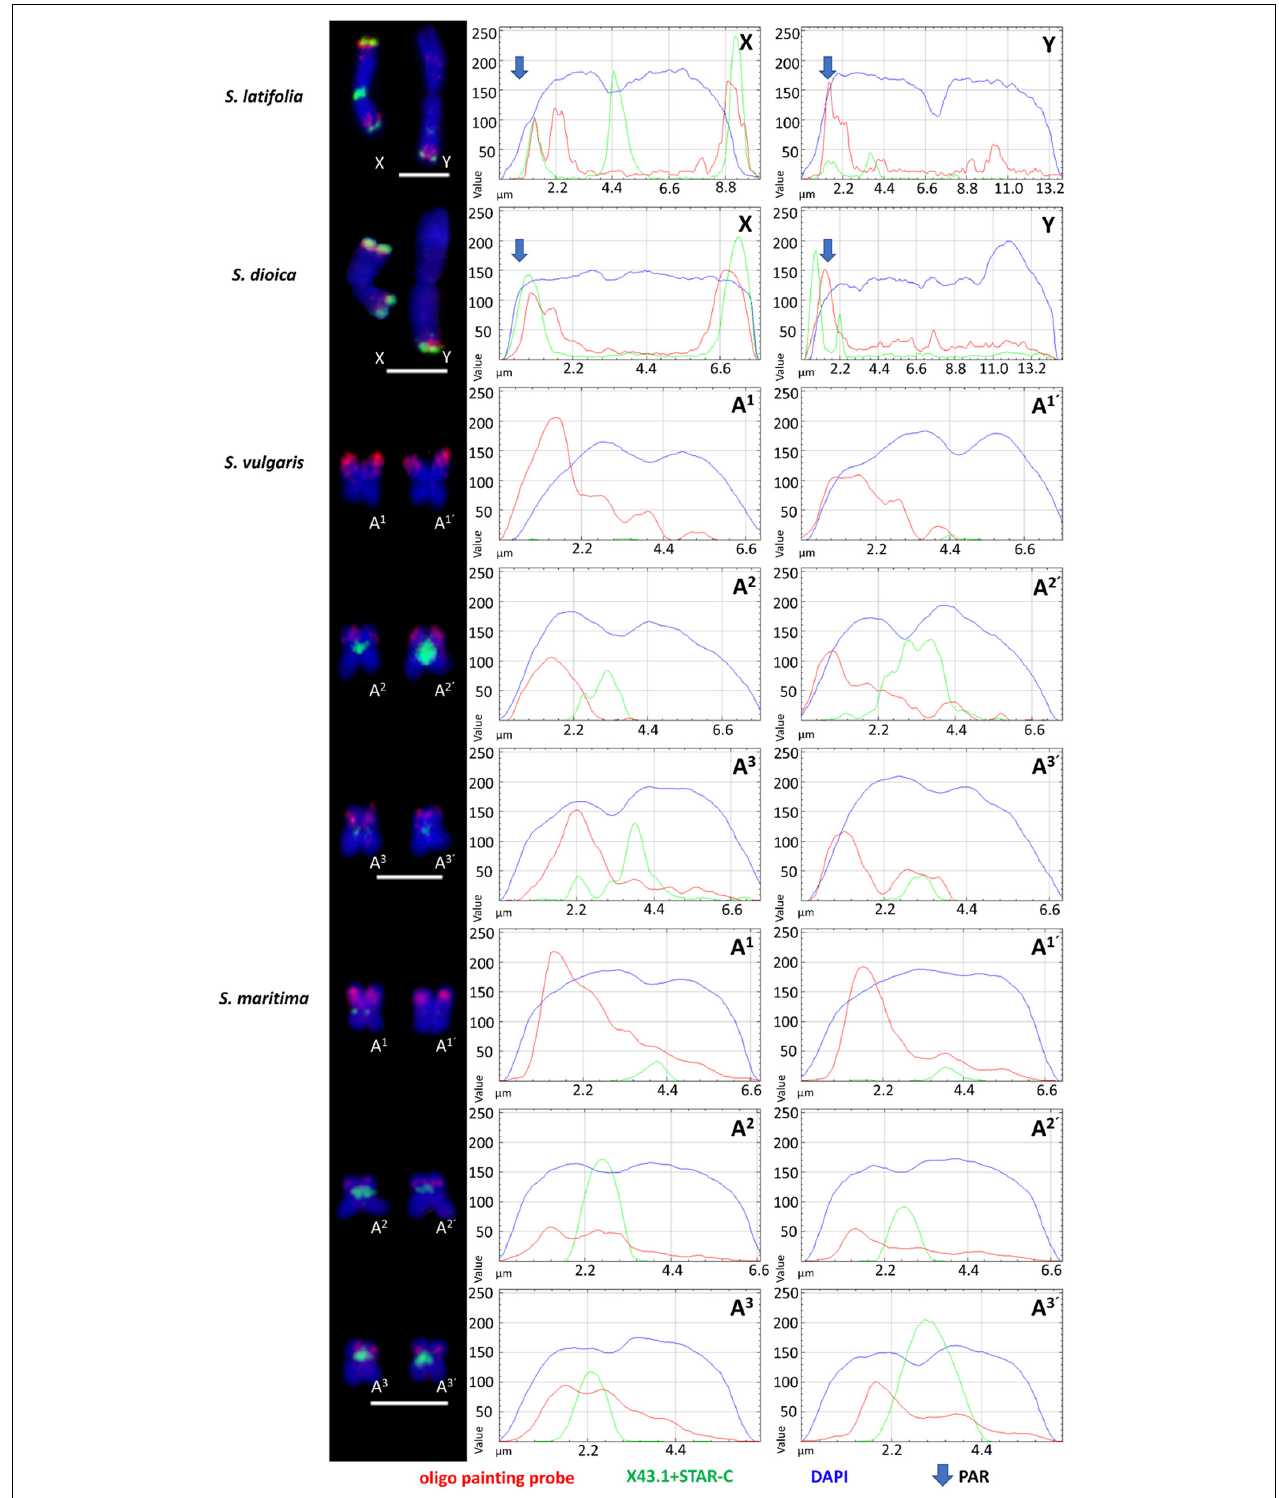
FIGURE 2 | Schematic distribution of X chromosome-specific oligo probe on sex chromosomes in S. latifolia and S. dioica and individual chromosomes in related gynodioecious species, S. vulgaris and S. maritima . Note the differences between X and Y chromosomes in S. latifolia and S. dioica . In S. vulgaris and S. maritima, the oligo painting probe signal is located on three pair of autosomes, numbered in this study as A 1 –A 3 and A 1 (cid:48) –A 3 (cid:48) . X43.1, a subtelomeric probe, is presented only on sex chromosomes and autosomes in S. dioica and S. latifolia . Scale bar = 5 µ m.